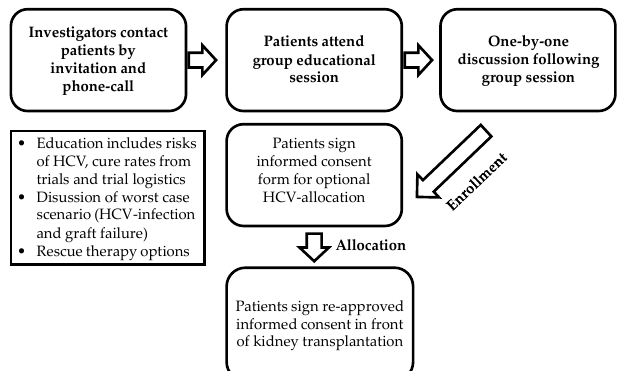
Figure 2. Process of informed consent. Eligible waiting list candidates were approached and educated (individually or in group sessions) on the potential risks and benefits of accepting a hepatitis C seropositive (HCV+) donor organ, the worst-case-scenario and rescue treatment options in case of resistant or refractory HCV virus infection.